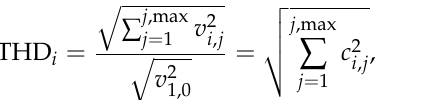
Aggregation Phases 1/50Hz, Mean 1,2,3,12,23,31